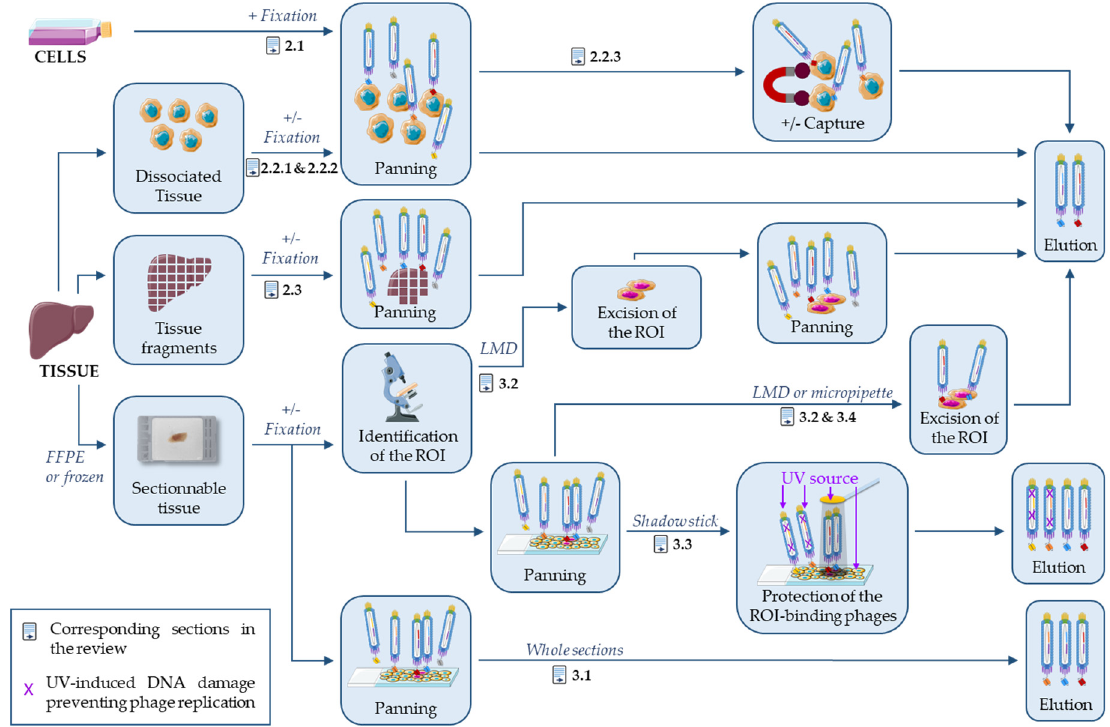
Figure 1. Panning strategies. This figure is a schematic view of the sample preparation and panning steps described in this review. The text sections corresponding to these different strategies are indicated in the figure. Except in one case, the reviewed publications used tissues for panning. Several publications additionally described strategies to select antibodies against particular cells or regions of interest (ROI), using magnetic cell sorting, excision of the ROI with laser-assisted microdissection (LMD) or with a micropipette, and the use of a shadow stick to protect the ROI-binding phages from UV-induced DNA damages. Although the on-slide panning can be carried out before the identification of the ROI, this was not shown here for clarity reasons. Some of the illustrations were obtained from Servier Medical Art library.